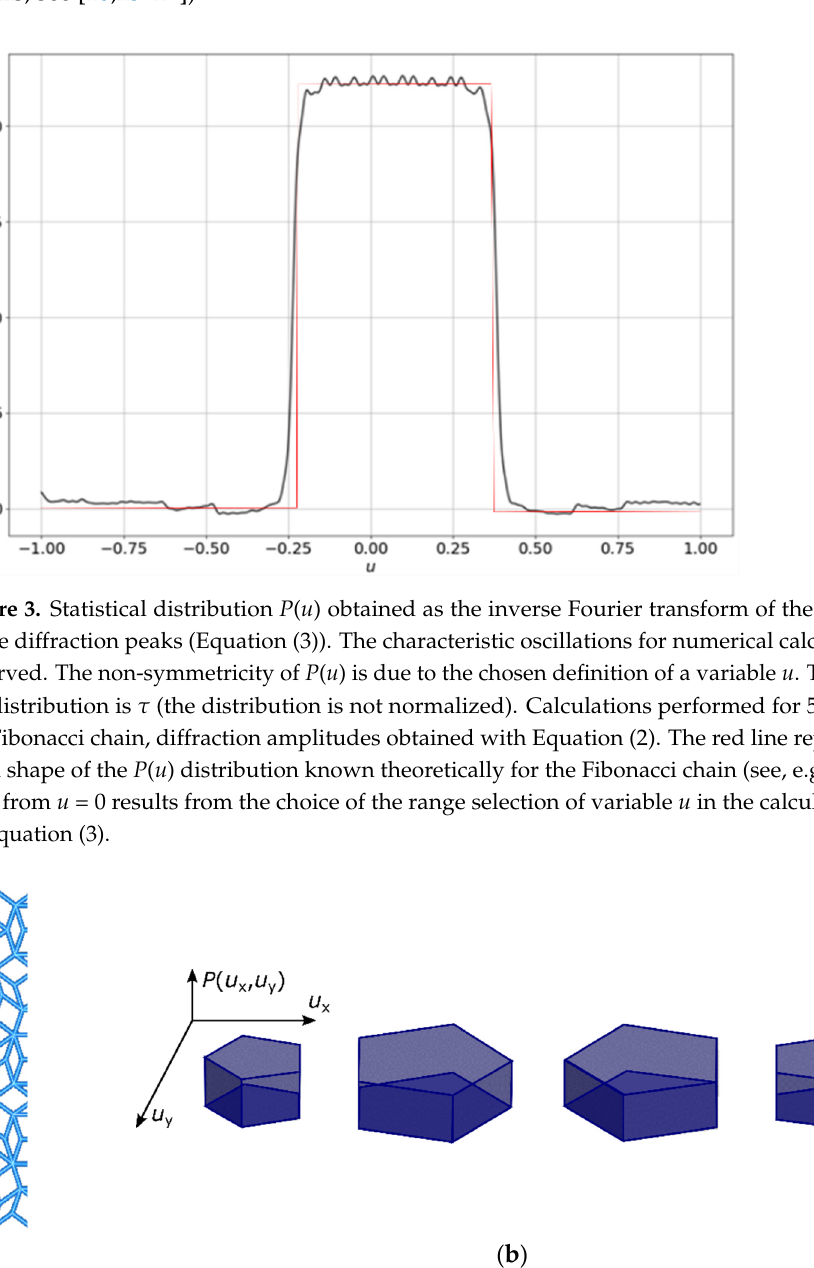
Figure 4. ( a ) Rhombic Penrose tiling as a quasicrystalline lattice to model decagonal quasicrystals. ( b ) The AUC for the Penrose tiling is a P ( u x , u y ) distribution consisting of four pentagons with uniform heights.